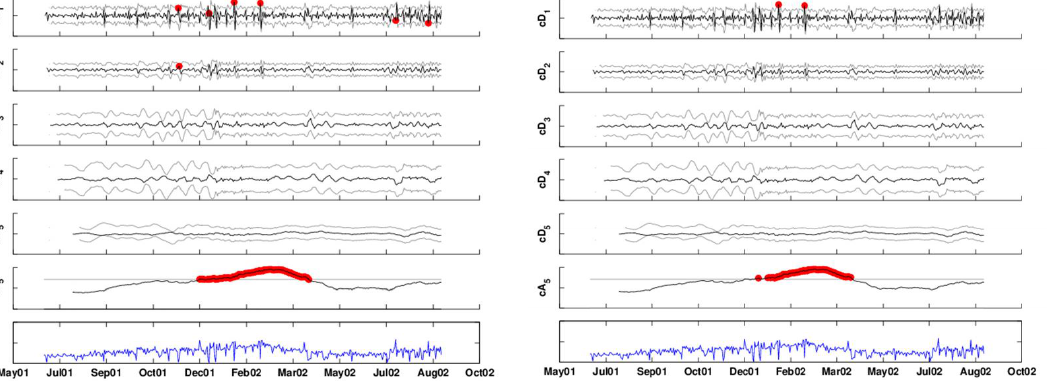
Monitoring each scale separately to account for autocorrelation: the detail coefficients (top five panels) are compared to control limits based on an AR(7) model. The approximation coefficients (sixth panel) are monitored by an EWMA chart. The bottom panel is the deseasonalized series. The left panel displays alarms based on exceeding thresholds. The right panel displays alarms after False Discovery Rate (FDR)